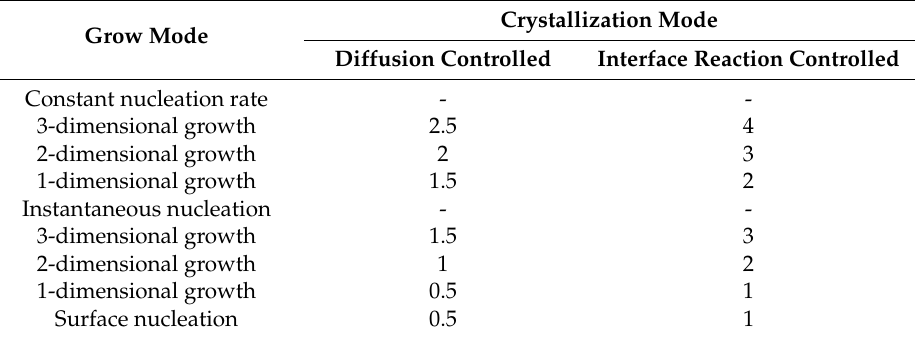
Table 5. Values of n for different nucleation and growth mechanisms. Grow